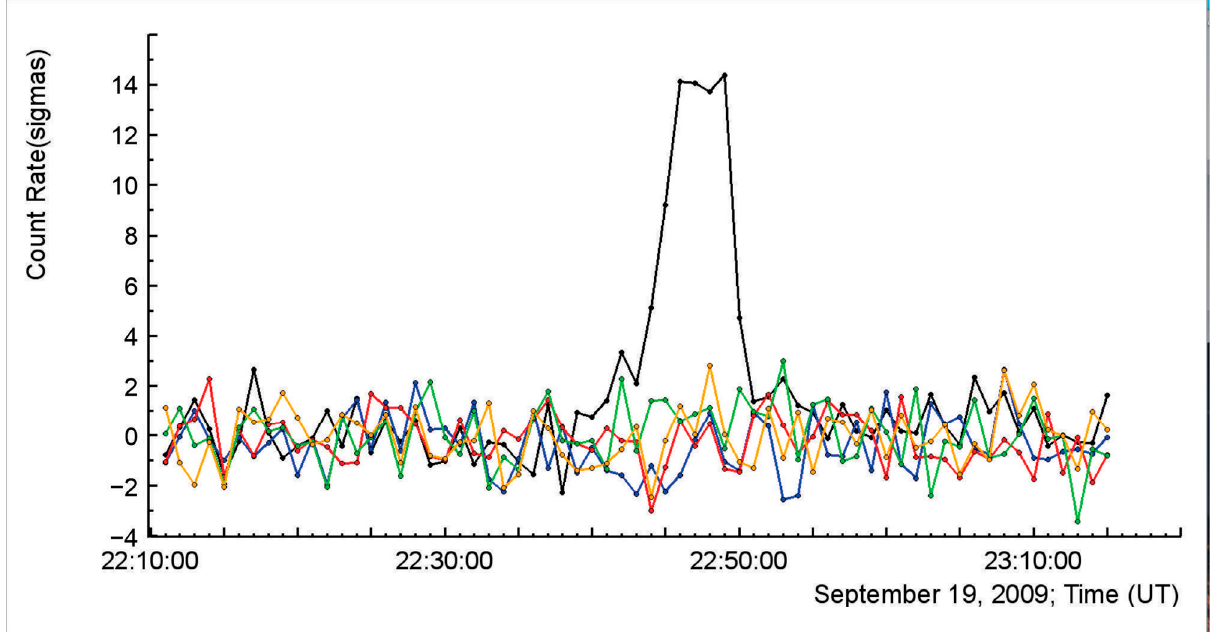
Figure 3. Time series of the count rates of particles arriving from different directions; black—vertical direction (coincidences of scintillators 1-5, 2-6, 3-7, and 4-8); blue—direction connected 1-6 and 3-8 scintillators; red—direction 1-7 and 2-8; green—direction 2-5 and 4-7; and yellow—direction 3-5 and 4-6. ©PRD. Reproduced with permission.